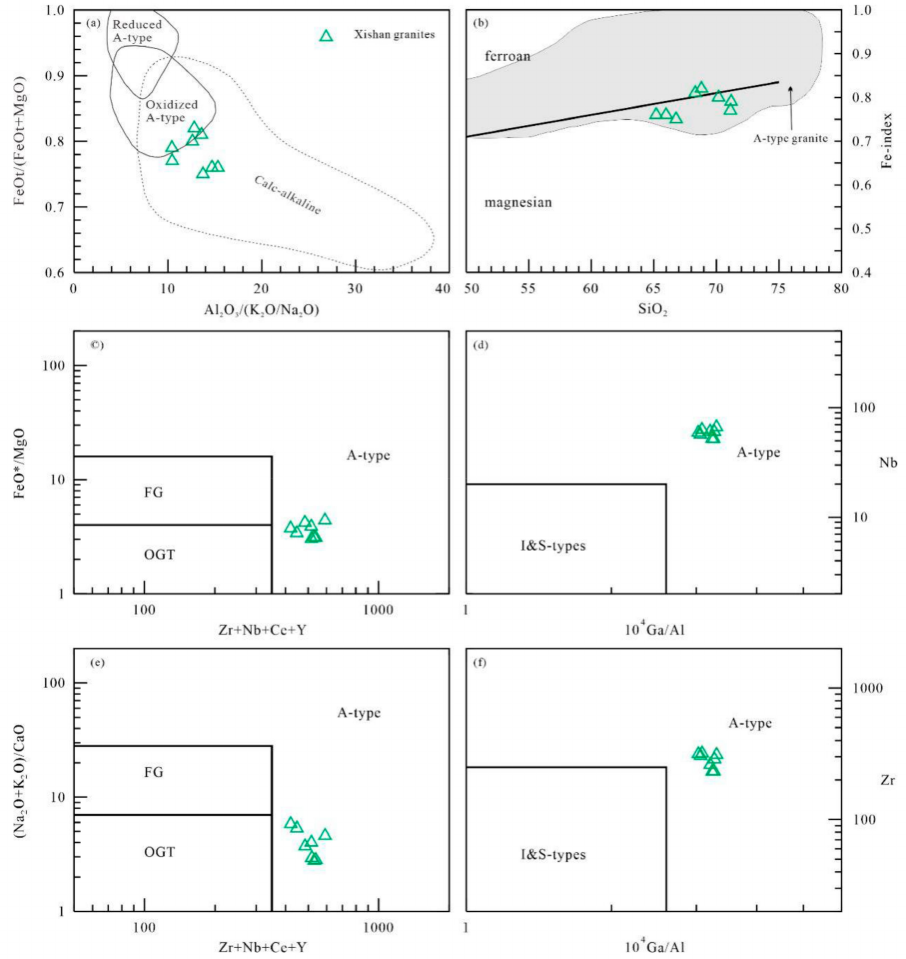
Figure 8. Discrimination diagrams of A-type granite for the Guiping complex. ( a ) Al 2 O 3 /(K 2 O/Na 2 O) versus FeO t /(FeO t + MgO) diagram (after [63]); ( b ) SiO 2 versus Fe-index diagram (after Frost et al., 2001) [67]; ( c ) (Zr + Nb + Ce + Y) versus FeO*/MgO diagram (after [67]); ( d ) 10,000Ga versus Nb diagram (after [63]); ( e ) (Zr + Nb + Ce + Y) versus (Na 2 O + K 2 O)/CaO diagram (after [63]); ( f ) 10,000 Ga versus Zr diagram (after